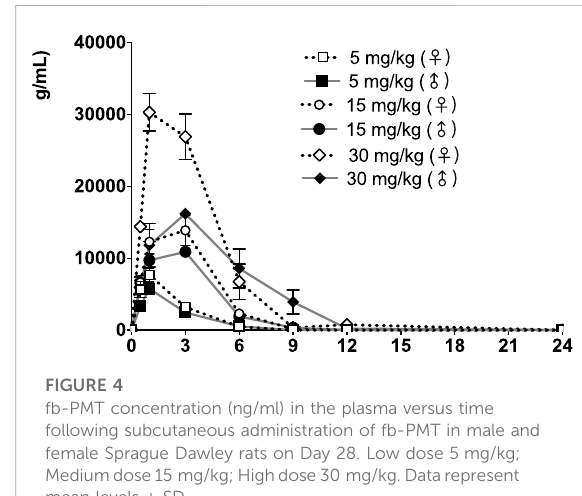
FIGURE 3 fb-PMT concentration (ng/ml) in the plasma versus time following subcutaneous administration of fb-PMT in male and female Sprague Dawley rats on Day 1. Low dose 5 mg/kg; Medium dose 15 mg/kg; High dose 30 mg/kg. Data represent mean levels ± SD.